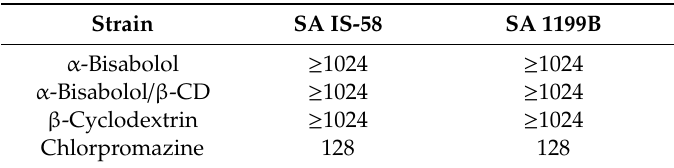
Determination of the minimum inhibitory concentration ( µ g / mL) of α -Bisabolol, α -Bisabolol / β -CD, β -Cyclodextrin, and Chlorpromazine. Strain SA IS-58 α -Bisabolol